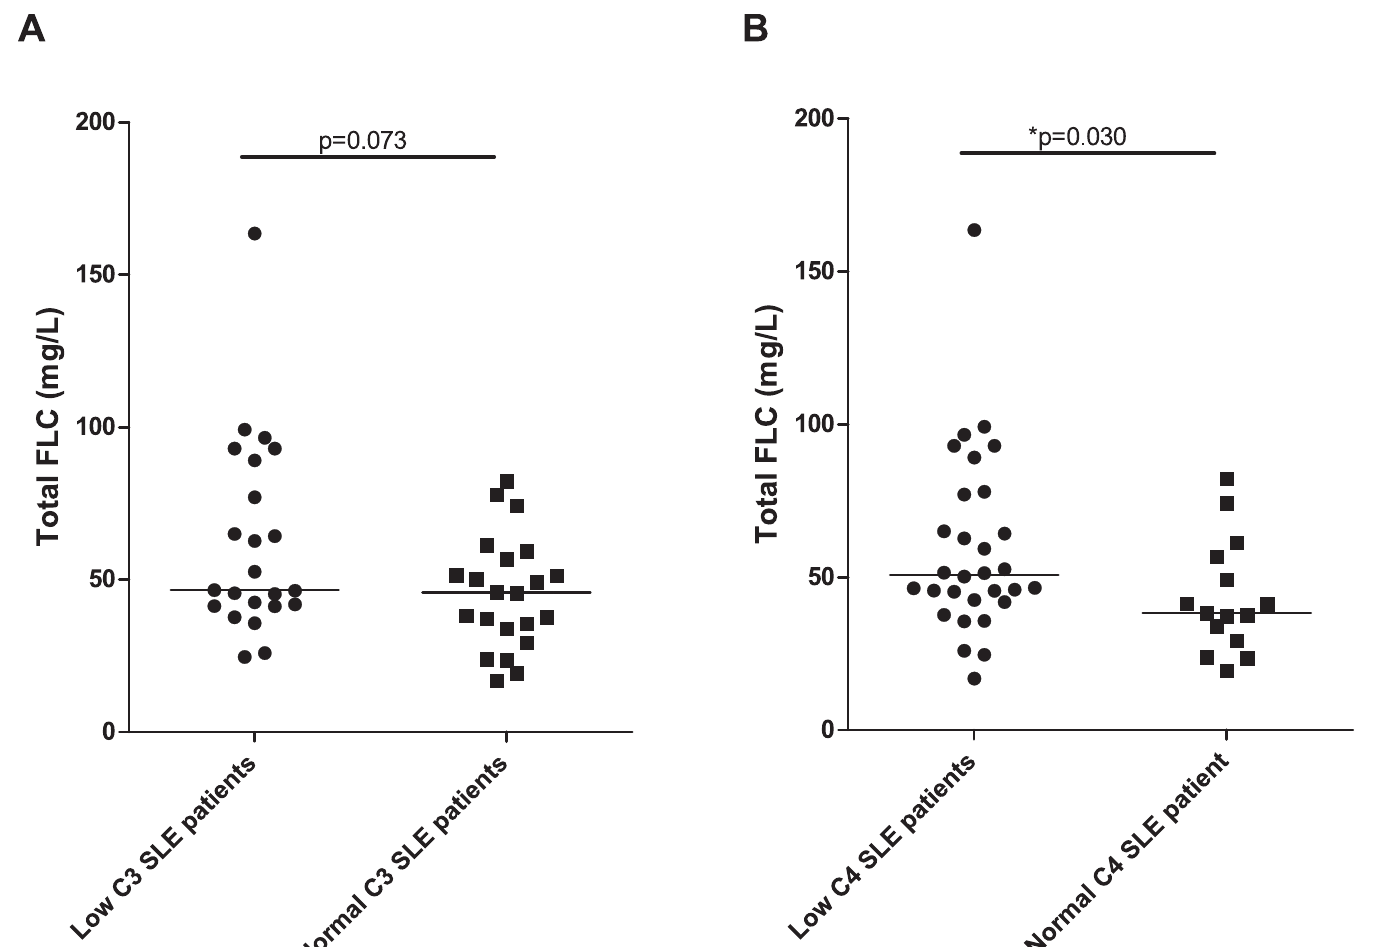
Fig 7. Concentrations of serum FLCs in SLE patients with low and normal levels of complement factors. Total FLC levels in SLE patients with low (n = 23)/normal (n = 22) C3 levels (A) (p = 0.073) and in SLE patients with low (n = 30)/normal (n = 15) C4 levels (B) (p = 0.030). Middle horizontal bars represent median and statistical significant differences are indicated with * , ** or *** for p-values less than 0.05, 0.01 or 0.001. FLCs — free light chains, SLE — systemic lupus